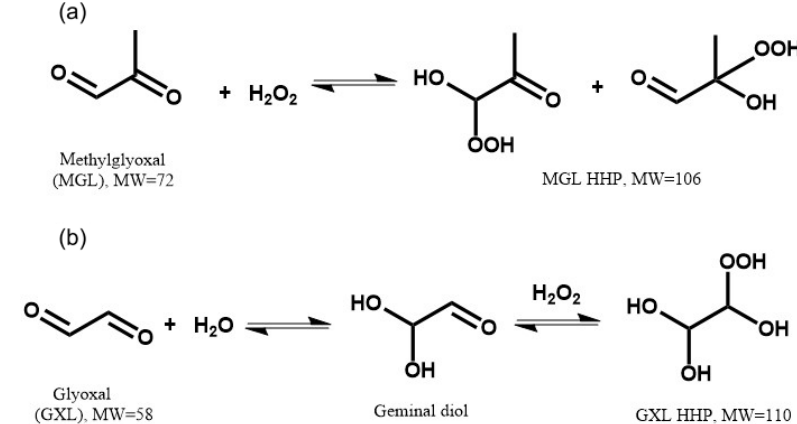
Figure 3. ROOH formation from reactions of H 2 O 2 with (a) methylglyoxal and (b) glyoxal.